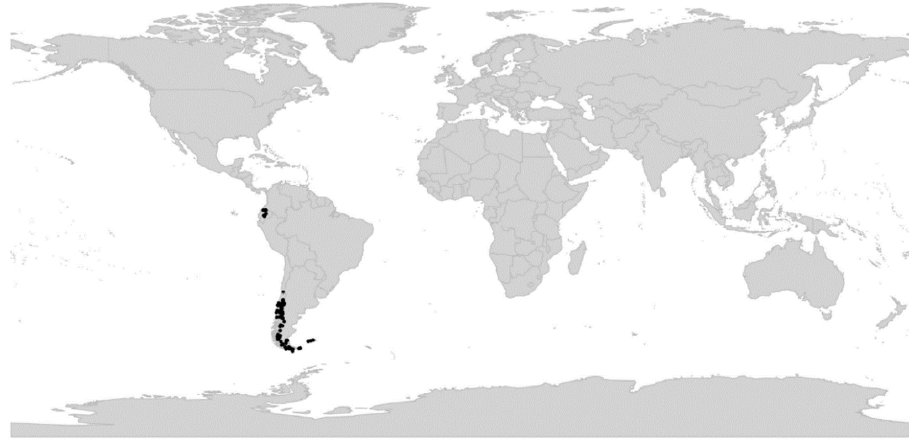
Figure 14. Global distribution of Viola sect. Chilenium .